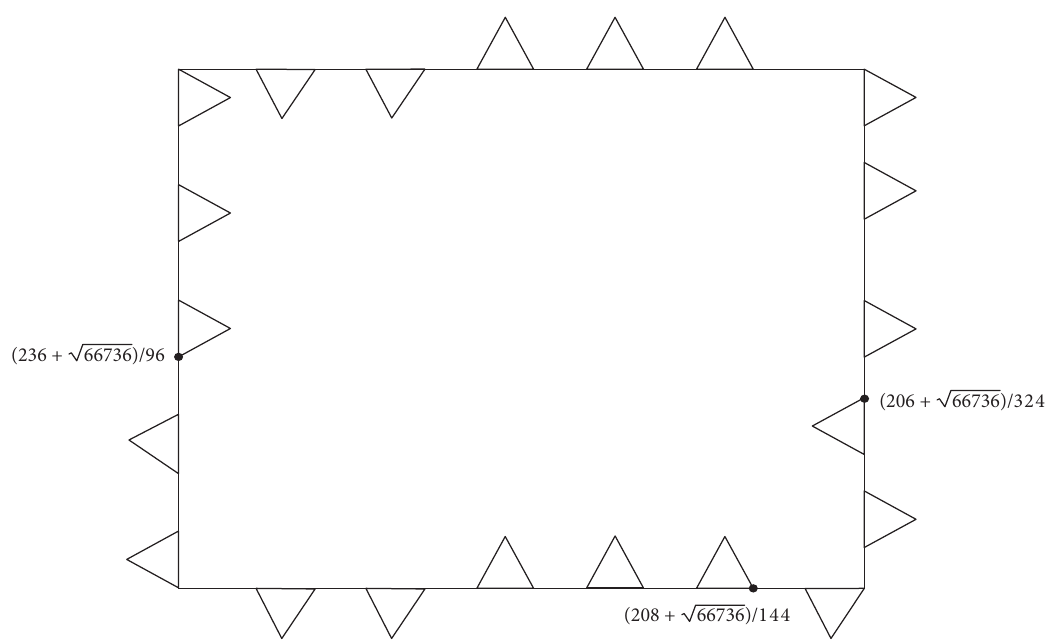
Figure 4: Shows the location of reduced numbers and describes that [ 6 , 5 , 4 , 3 , 2 , 1 ] ∼